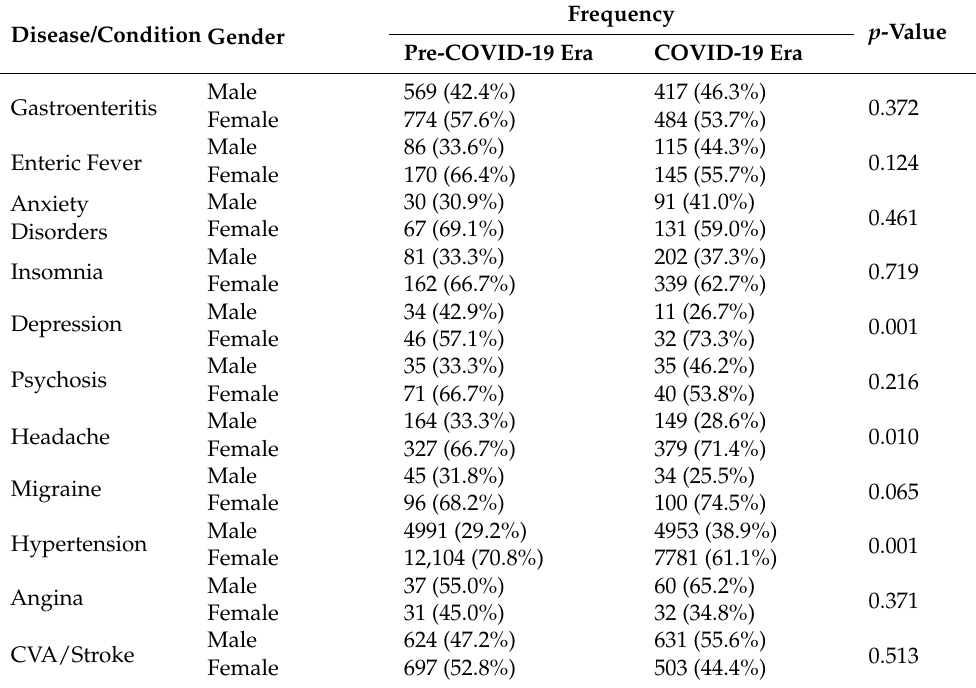
Table 8. Relationships between gender and the prevalence of the diseases in the pre-COVID-19 and COVID-19